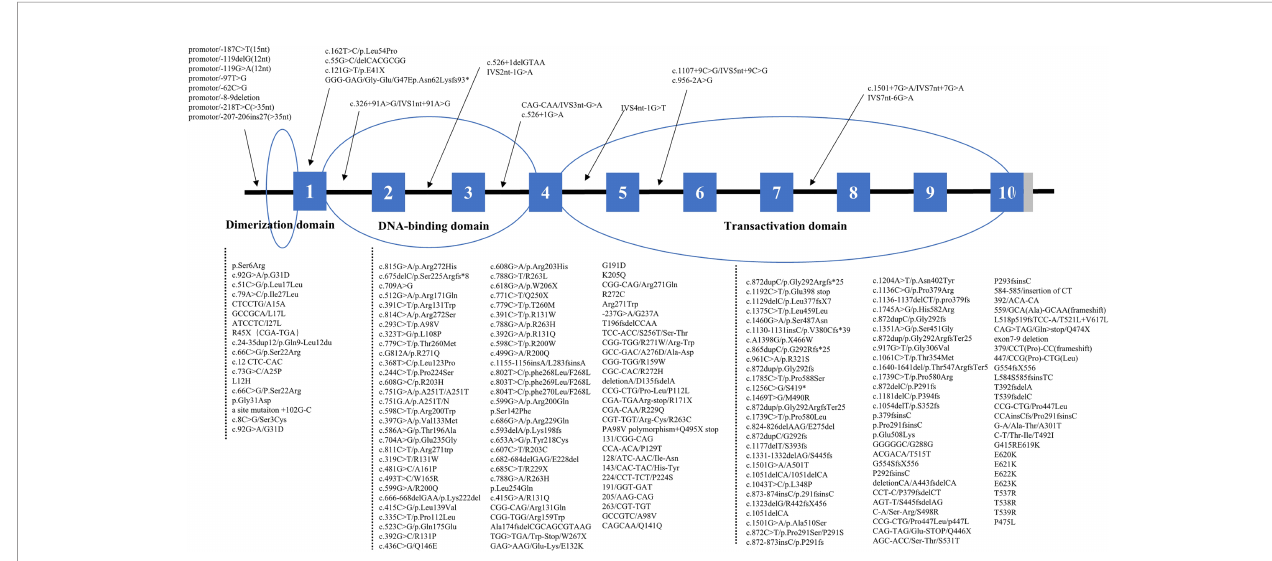
FIGURE 2 | Distribution of HNF1-alpha mutations. *means nucleotide number and indicates translation stop codon.